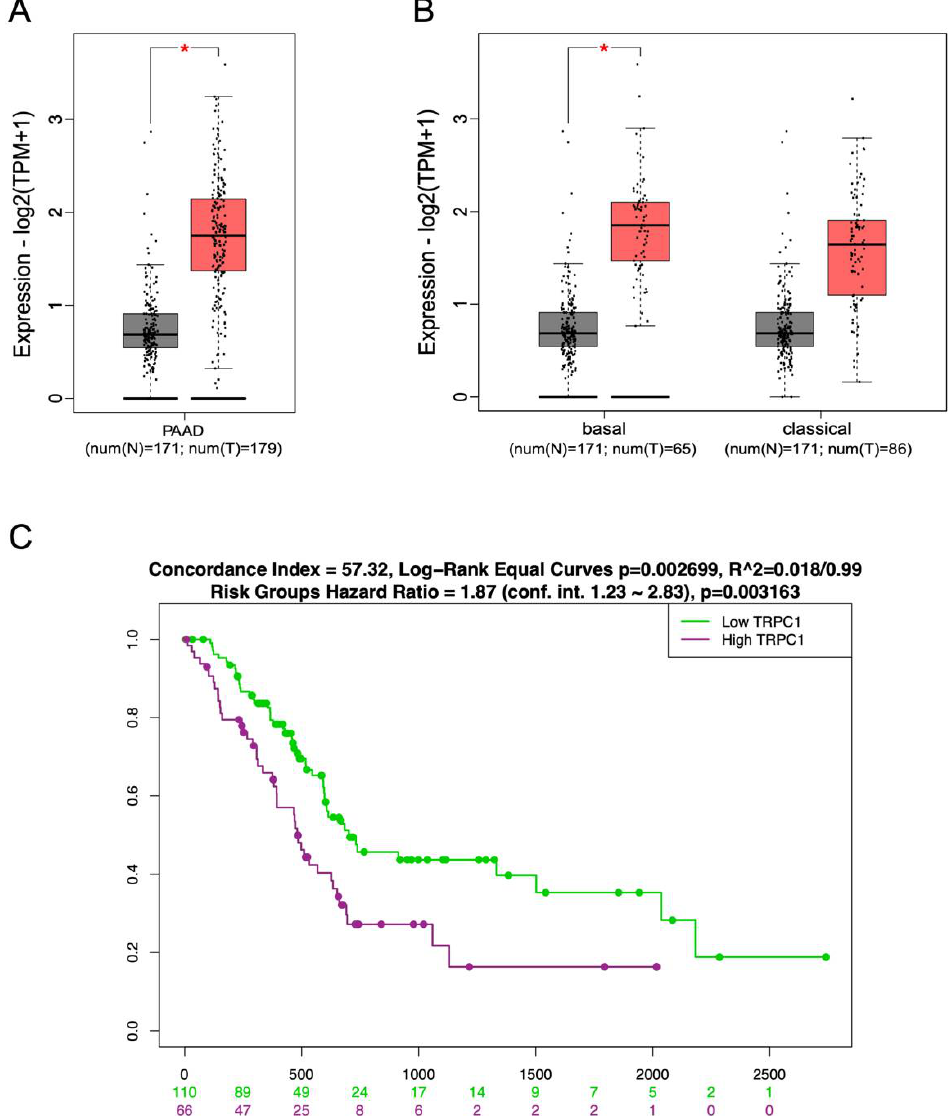
Figure 1. TRPC1 overexpression correlates with poor overall survival in PDAC patients. ( A ) Whisker boxplots of TRPC1 mRNA expression in normal samples (N) and PDAC tumor tissues (T) were generated by GEPIA2 using data from The Cancer Genome Atlas (TCGA) cohort PAAD and Genotype-Tissue Expression (GTEx) samples. * Indicates p < 0.01. ( B ) Whisker boxplots of TRPC1 mRNA expression in normal samples (N) and PDAC tumor tissues (T) in both the basal and classical subtypes of PDAC were generated by GEPIA2 using data from the TCGA cohort PAAD and GTEx samples. * Indicates p < 0.01. ( C ) Overall survival analysis of patients within the PAAD cohort with either a high or low expression of TRPC1 was generated using SurvExpress. The Kaplan–Meier curve was analyzed using the optimized SurvExpress Maximize algorithm. The number of analyzed patients across time (days) is indicated below the horizontal